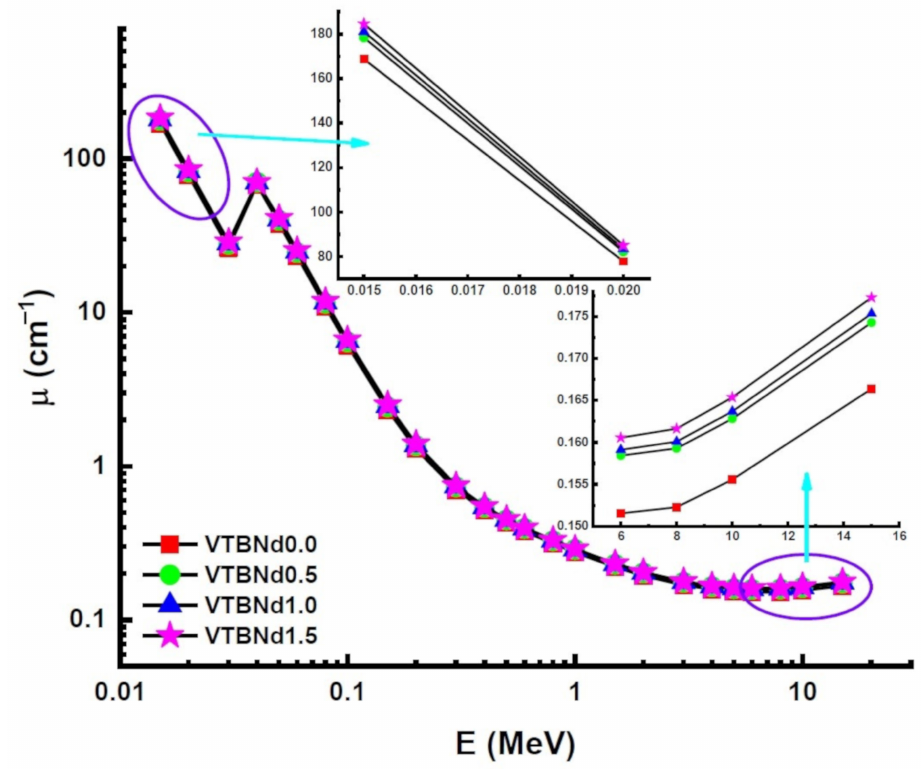
Figure 2. Variation of linear attenuation coefficient ( µ m) against photon energy for all